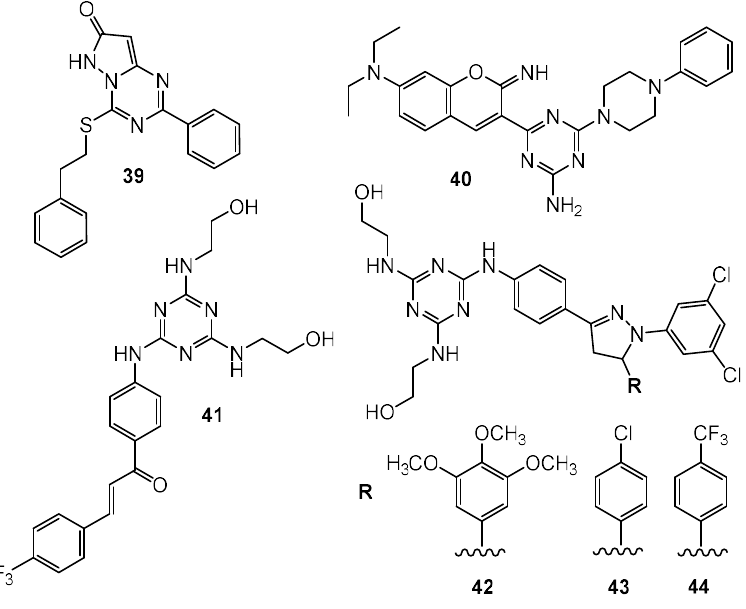
Figure 10. Structures of compounds 39–44 .